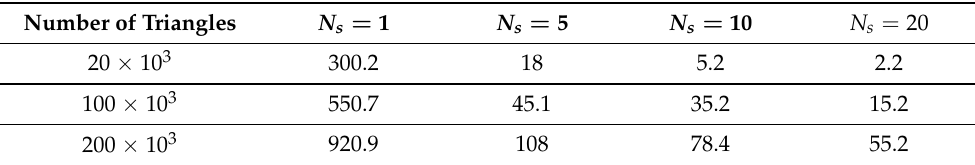
Table 1. Wall-time ( sec ) of the pre-step for small, medium and large triangulations, and an increasing number of subdivisions, ranging from N s = 1 to N s =